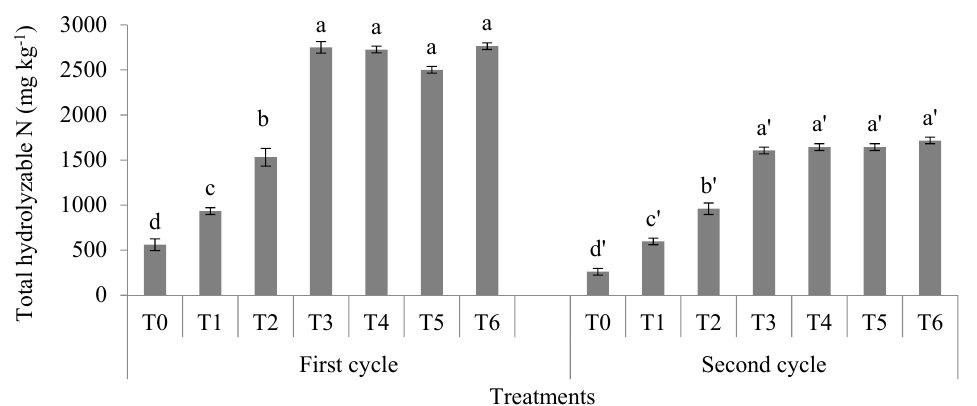
Figure 2. Effects of treatments on soil total hydrolyzable nitrogen. Means with the same letter above the bars within a crop cycle are not significantly different at p ≤ 0.05. Bars represent the mean values ± standard error.